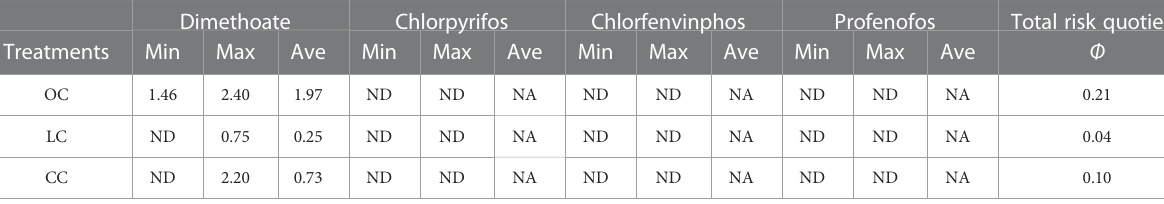
TABLE 2 Soil pesticide residues in different cultivation/mg kg -1.